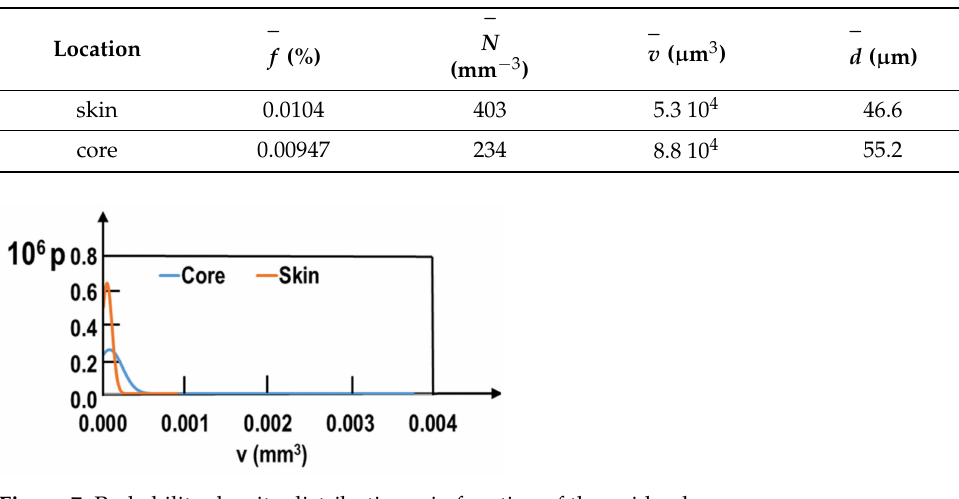
Figure 7. Probability density distribution p in function of the void volume v.